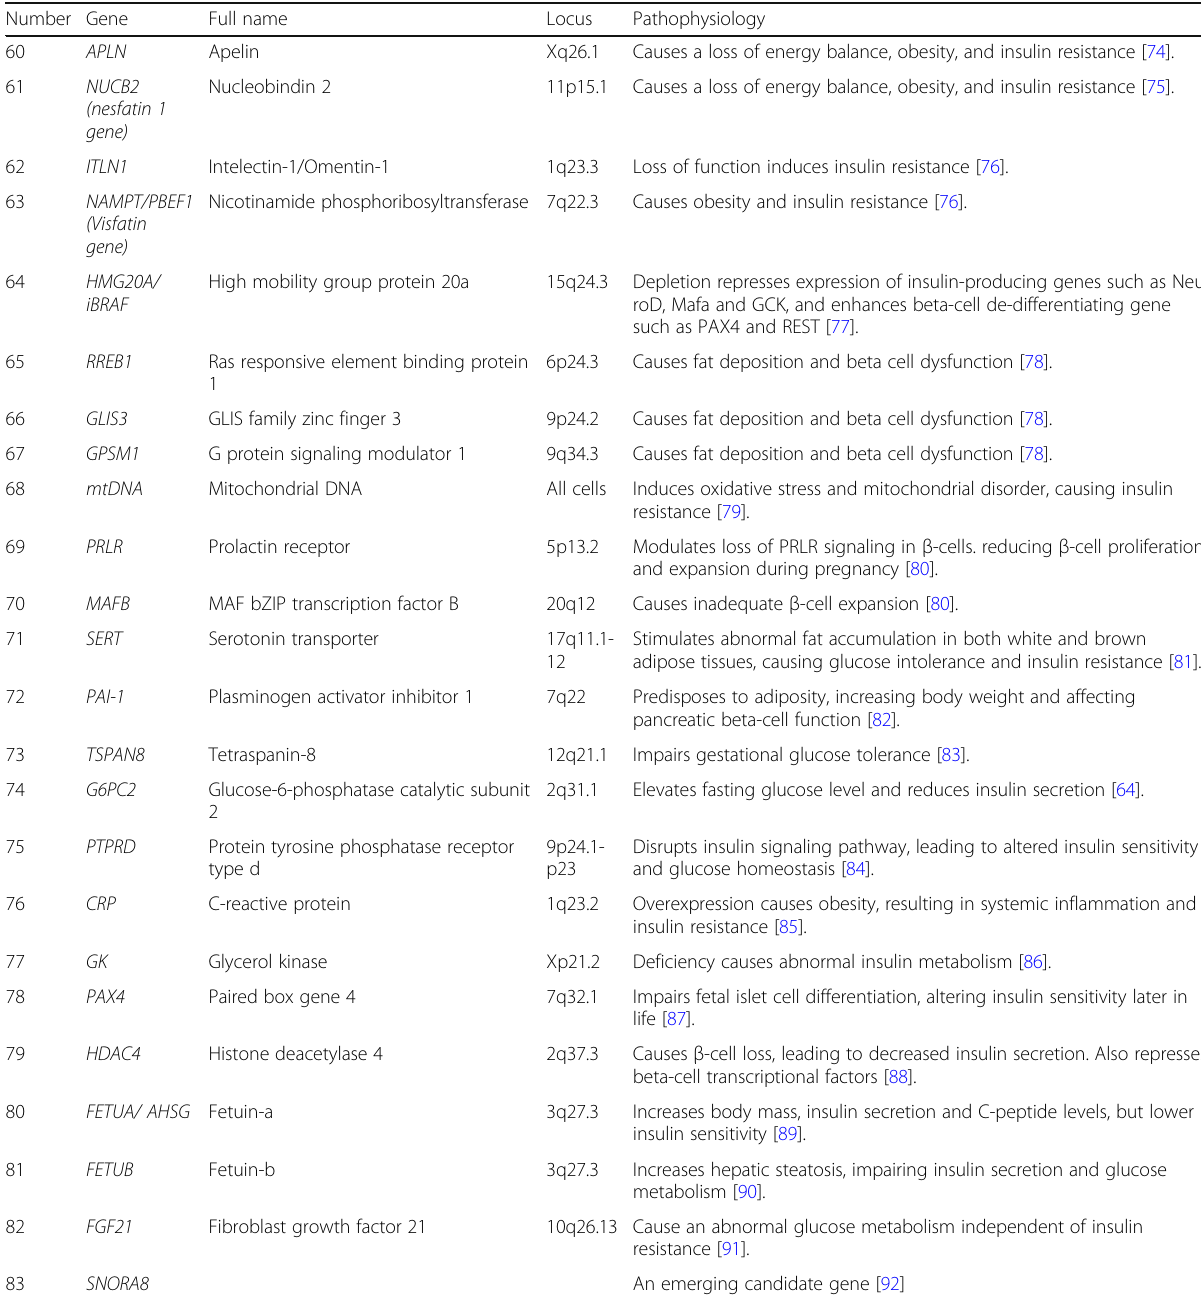
Table 1 GDM predisposing genes showing locations and phathophysiology (Continued) Number